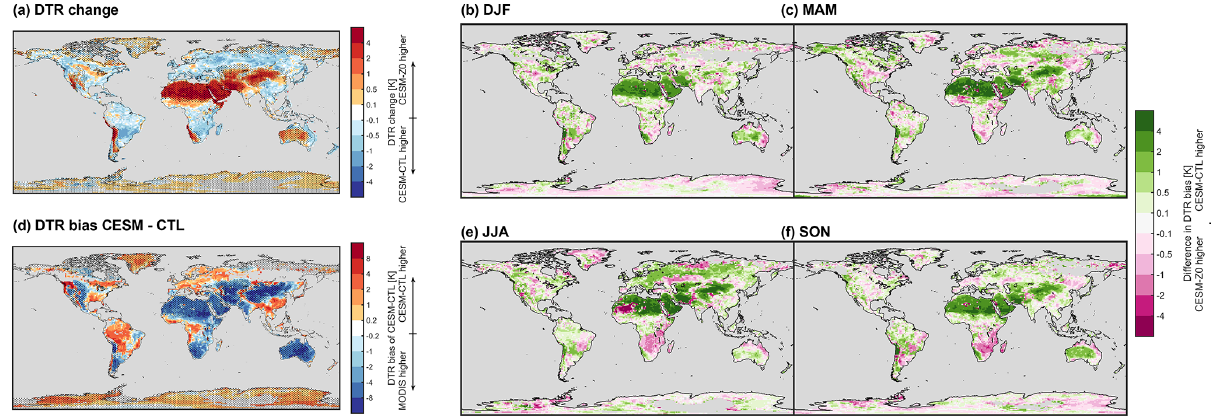
Figure 11. As Fig. 8 but for land–atmosphere coupled simulations CESM-Z0 and CESM-CTL. CESM data are cloud masked.